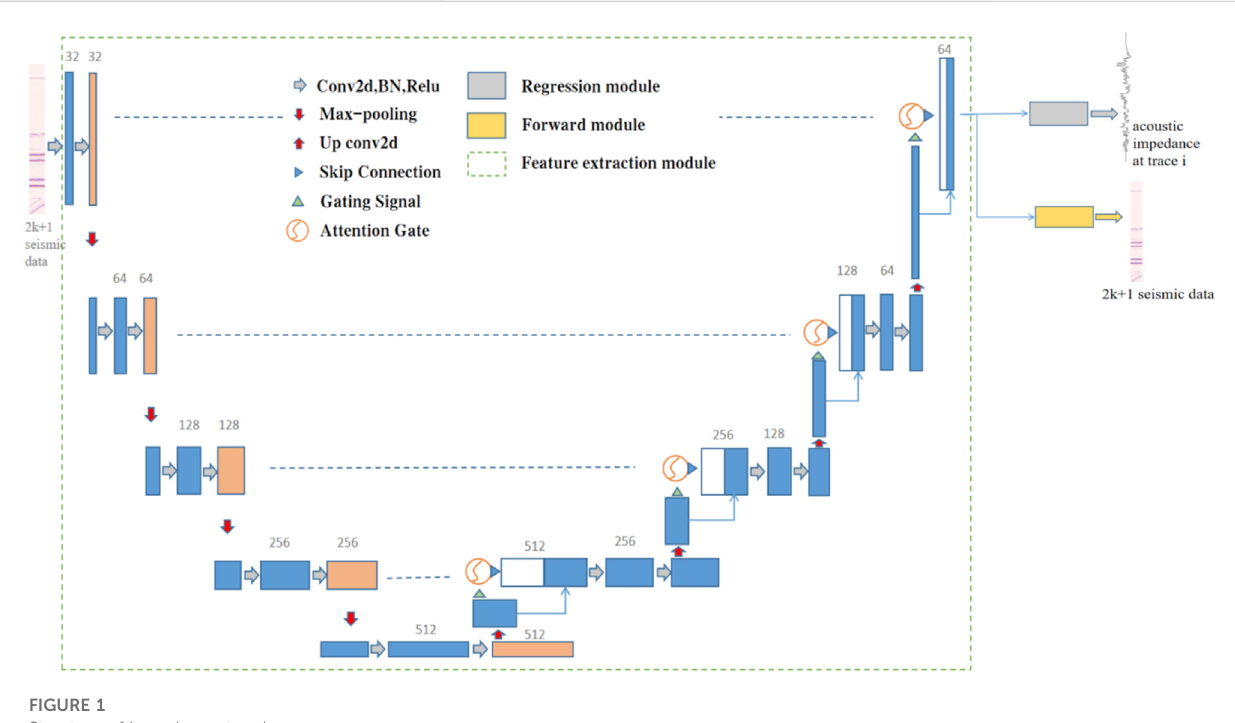
FIGURE 1 Structure of inversion